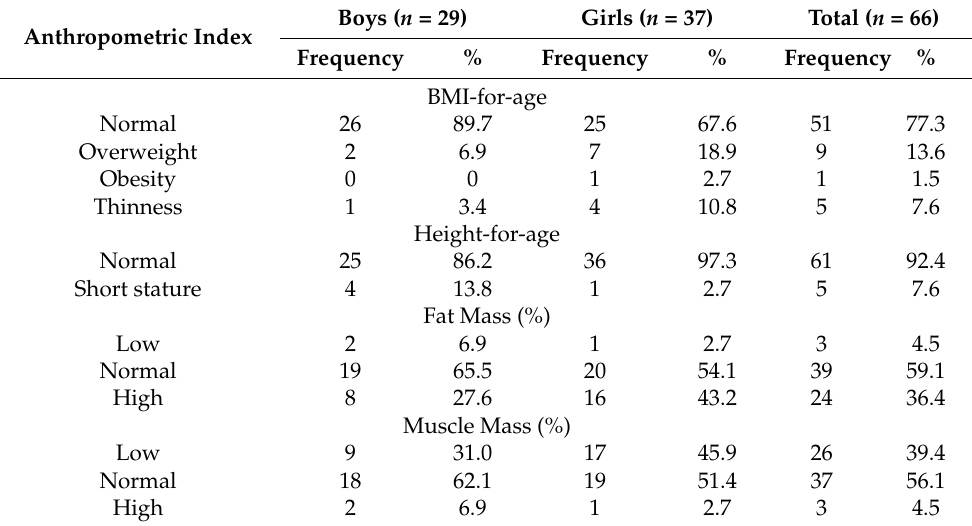
Table 3. BMI-for-age, height-for-age, fat mass, and muscle mass of children ( n = 66) with CD following the Ministry of Health GFD